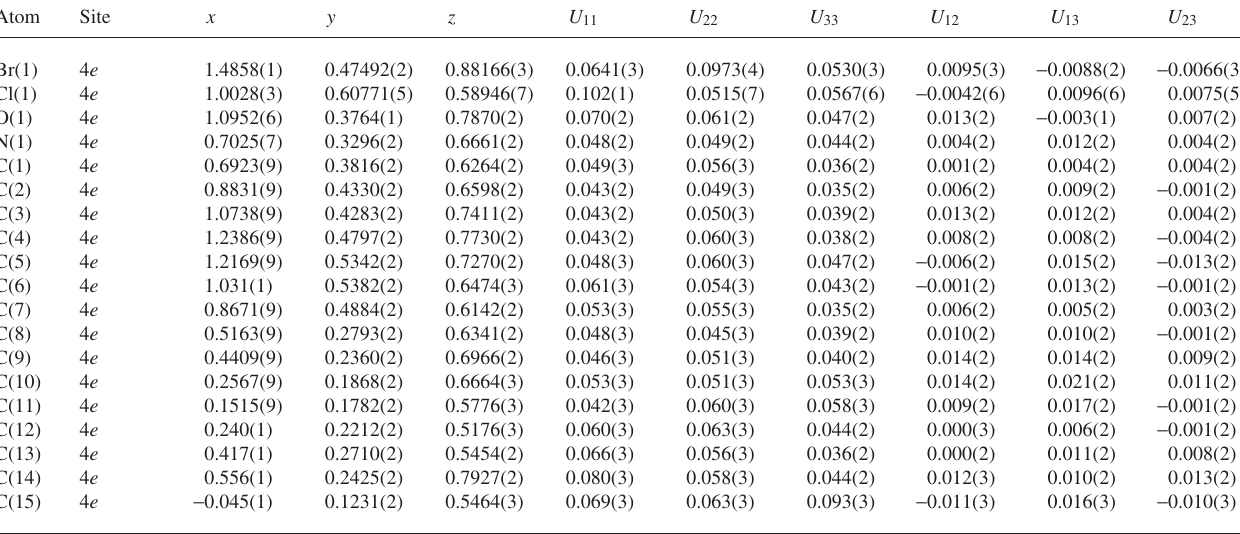
Table 3. Atomic coordinates and displacement parameters (in Å 2 )